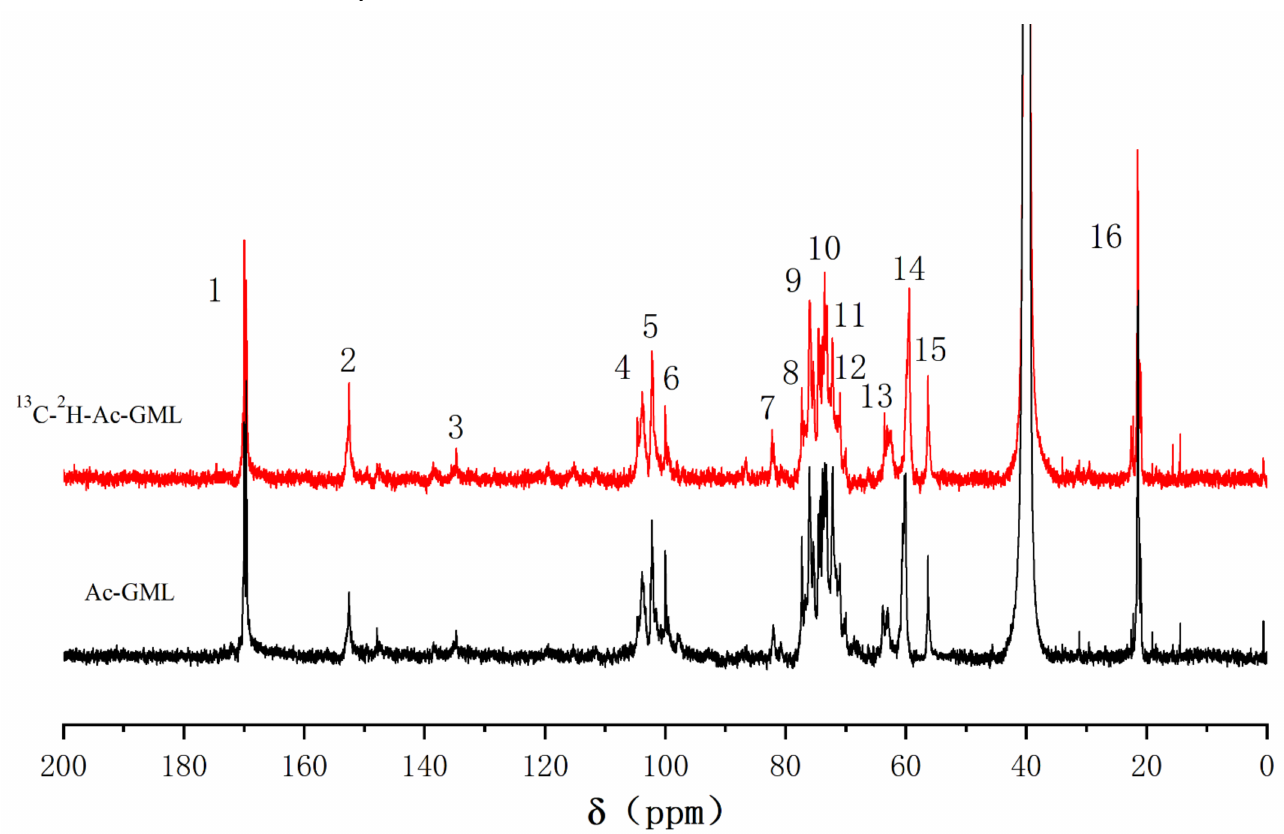
Figure 6. 13 C-NMR spectra of Ac-GML from ginkgo